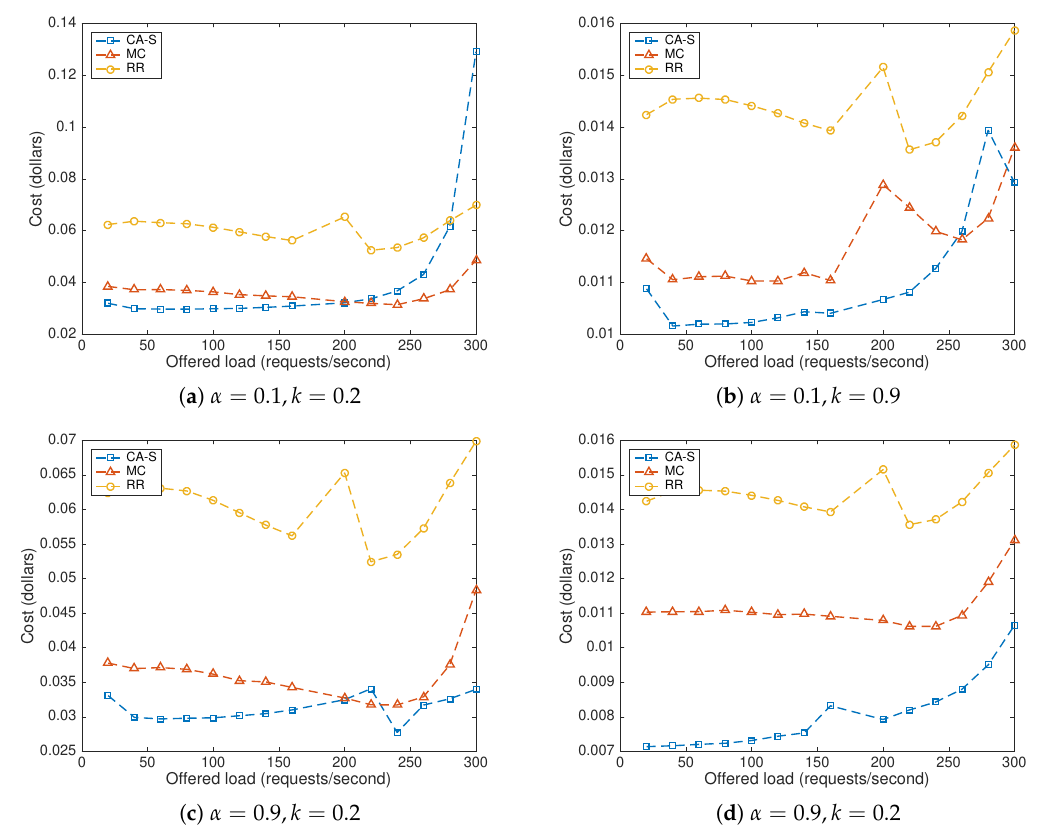
Figure 10. Combined cost with CA-S in price